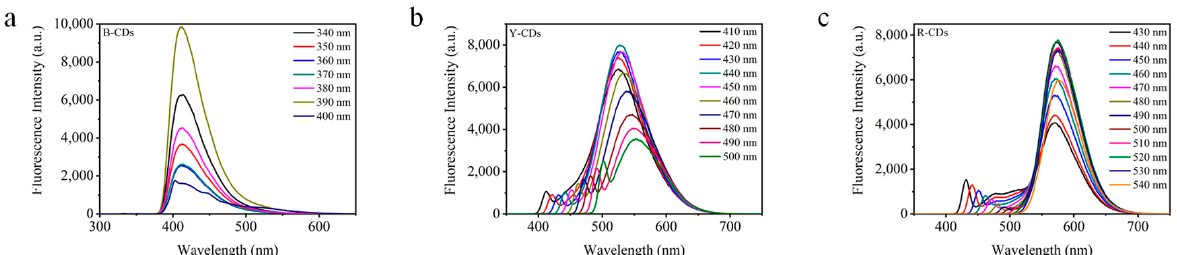
Figure 5. The fluorescence emission spectra of the ( a ) B-CDs, ( b ) Y-CDs and ( c ) R-CDs solutions at di ff erent excitation wavelengths.